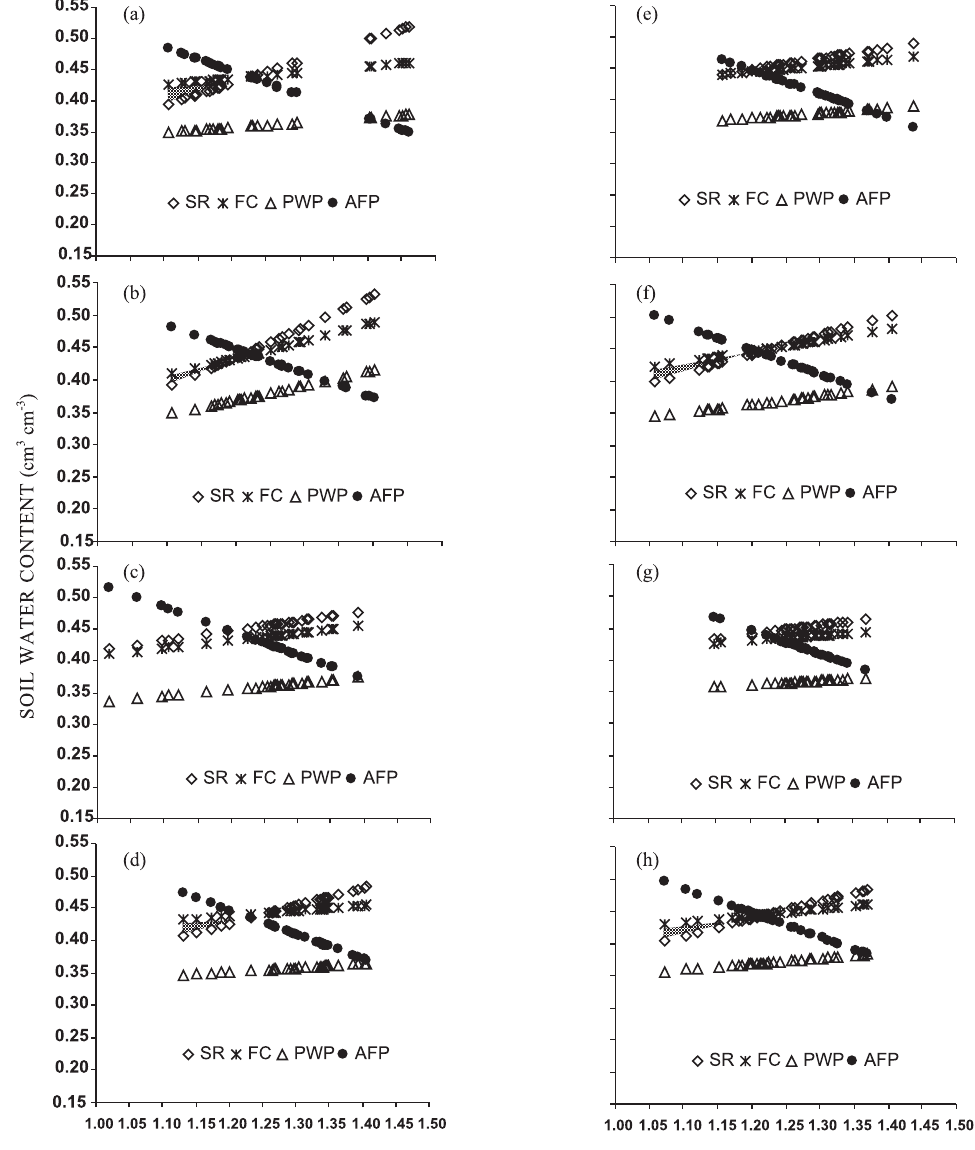
Figure 2. Soil water content ( θθθθθ ) as affected by soil bulk density, at the critical levels of field capacity (FC = -0.01 MPa), permanent wilting point (PWP = -1.5 MPa), air-filled porosity (AFP = 10 %) and soil penetration resistance (SR = 2MPa). Samples collected in the 20–40 cm layer, in the first year of the experiment. The shaded area represents the LLWR. (a) sunflower+millet; (b) sunflower+forage sorghum; (c) sunflower+sunn hemp; (d) sunflower+chiseling; (e) triticale+millet; (f) triticale+forage sorghum; (g) triticale+sunn hemp; (h)